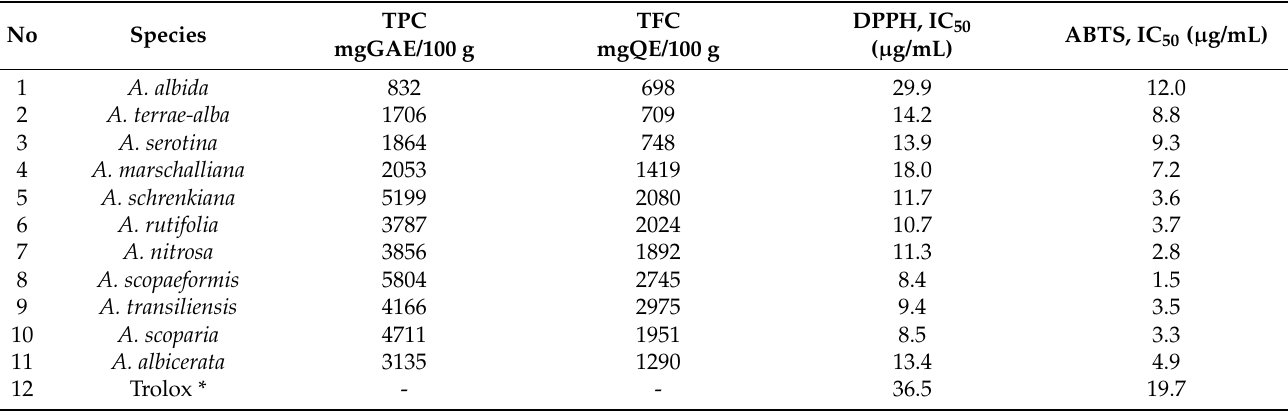
Figure 6. Correlation between the TPC and RSA of Artemisia species. Table 5. Antioxidant potentials of Artemisia